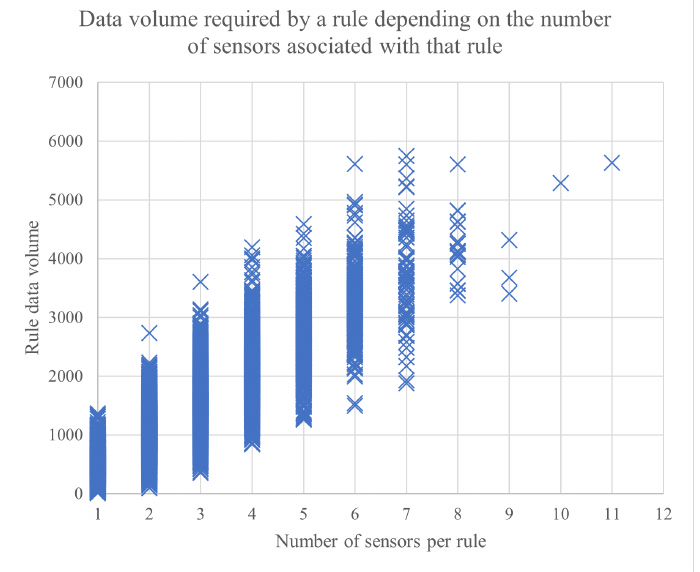
Figure 7. The data volume required by a rule, depending on the number of sensors associated with that rule.